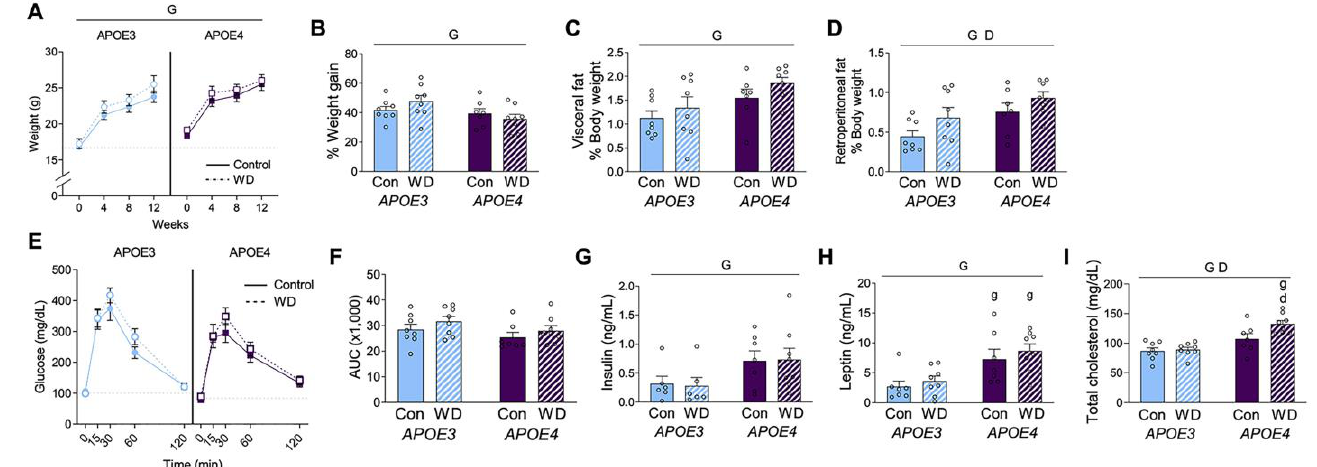
Figure 1. Metabolic profiles in APOE mice after Western diet. ( A ) Body weight was measured at the start and at four-week intervals in female APOE mice on control (Con; open circles) and Western diet (WD; filled squares). The dotted line indicates the initial weight of the APOE3 mice. ( B ) The percent weight change was calculated from the beginning to the end of the experimental period. ( C , D ) Fat pads from ( C ) visceral and ( D ) retroperitoneal depots were removed and weighed at the conclusion of the experiment. Values are expressed as a percentage of body weight. ( E ) Results from an oral glucose tolerance test that was administered after 12 weeks of diet. ( F ) The area under the curve was calculated for the GTT. ( G – I ) Plasma was collected under fasting conditions at the end of the experiment and measured for ( G ) insulin, ( H ) leptin, and ( I ) cholesterol. Data are shown as individual values (open circles) and mean values (+SEM) from n = 7–8 mice per group. “G” indicates a significant main effect of the APOE genotype, “D” indicates a significant main effect of diet, “g” indicates a significant difference from the APOE3 mice on the same diet, “d” indicates a significant difference from animals with the same APOE genotype on the control diet. Significance is p < 0.05. Metabolites 2023 , 13 , x FOR PEER REVIEW